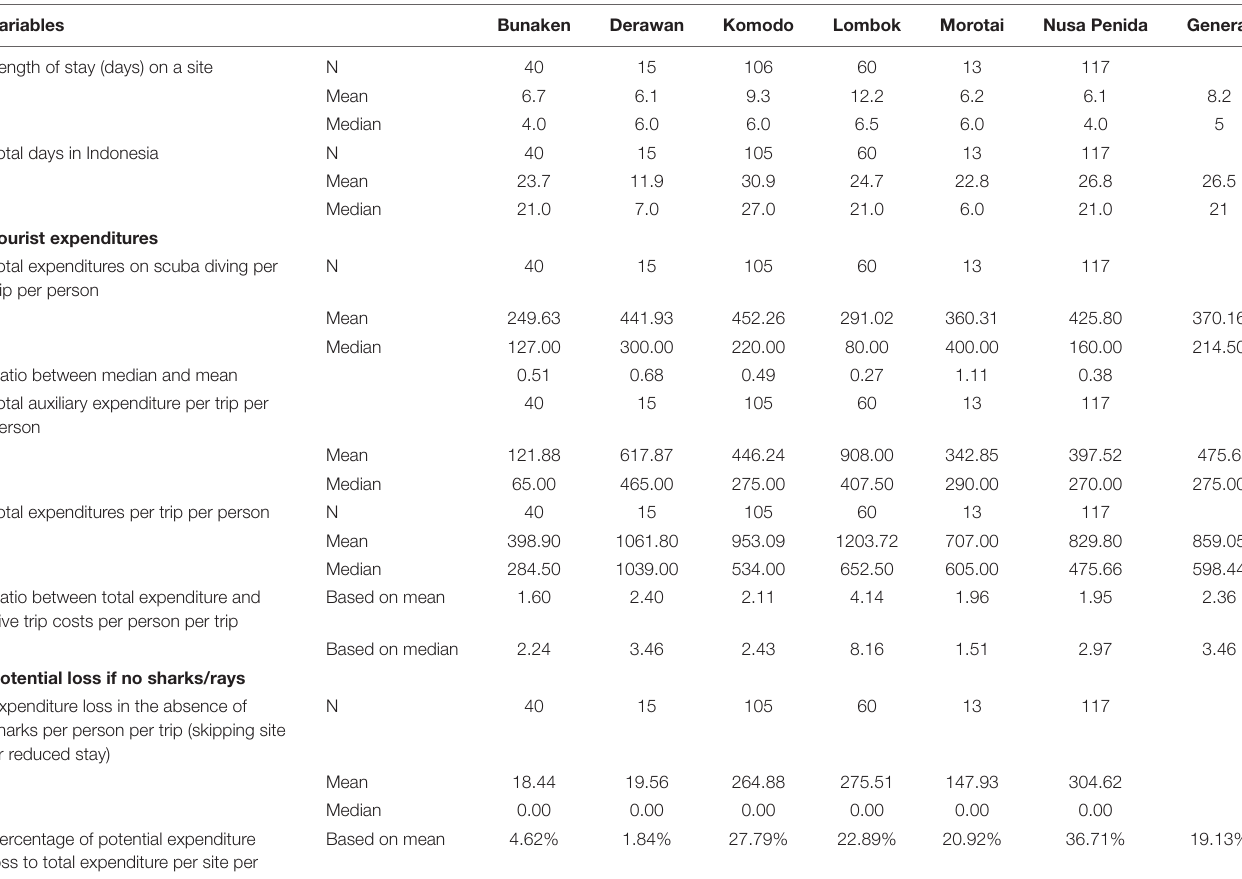
TABLE 1 | Visitor expenditures across six sampled sites (USD, 2017). Variables Bunaken Derawan Length of stay (days) on a